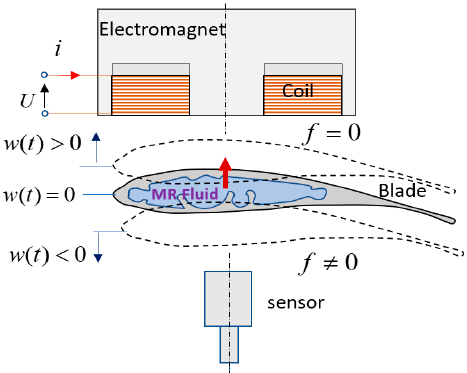
Figure 10. Control principle of the blade vibrations.